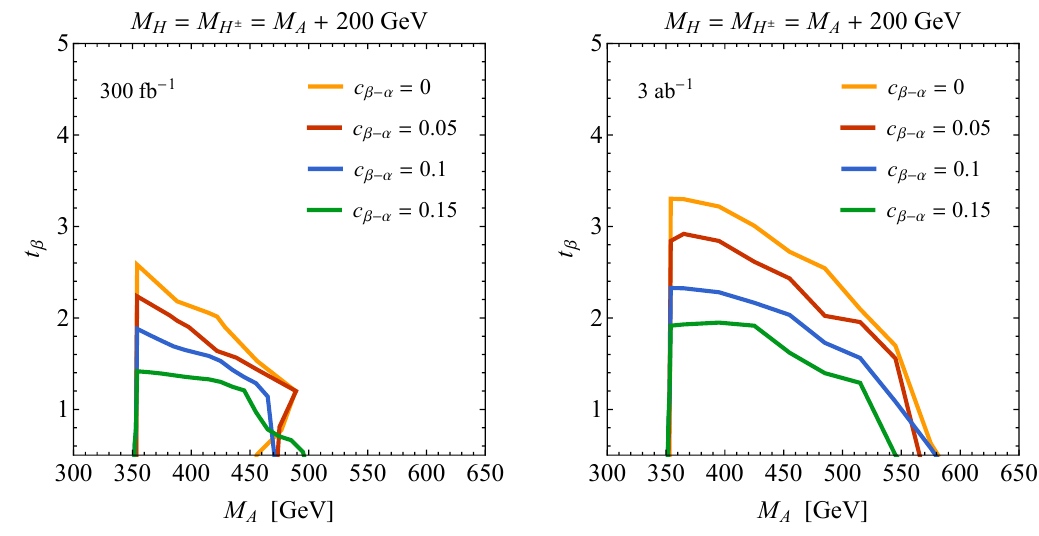
Figure 10 . 95% CL limits on t (cid:12) in the type-II 2HDM resulting from a hypothetical t (cid:22) tZ search. The p (cid:0) (cid:1) results shown on the left (right) are based on 300 fb (cid:0) 1 3 ab (cid:0) 1 of LHC data taken at s = 14 TeV. They employ M H = M = M A + 200 GeV, (cid:21) 3 = 6 and assume four di(cid:11)erent values of c (cid:12) (cid:0) (cid:11) as H (cid:6) indicated in the legend of each plot. The regions below the coloured contours represent the excluded parameter